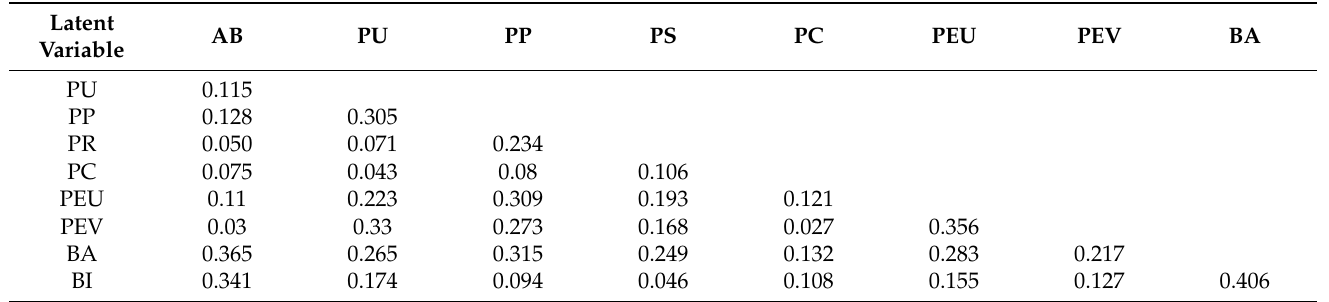
Table 7. Discriminant validity matrix (heterotrait–monotrait ratio, HTMT).